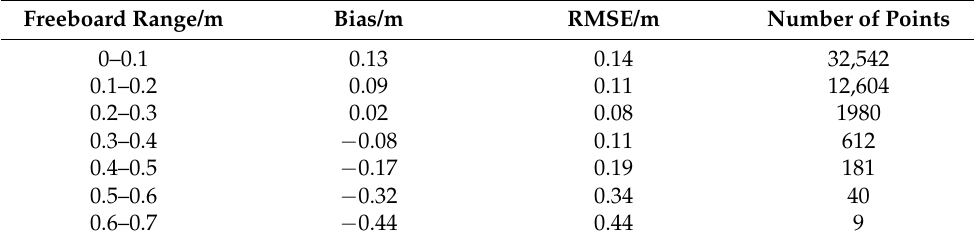
Table 6. Bias between the freeboard from this study and that from AWI in different freeboard ranges. Freeboard Range/m Bias/m